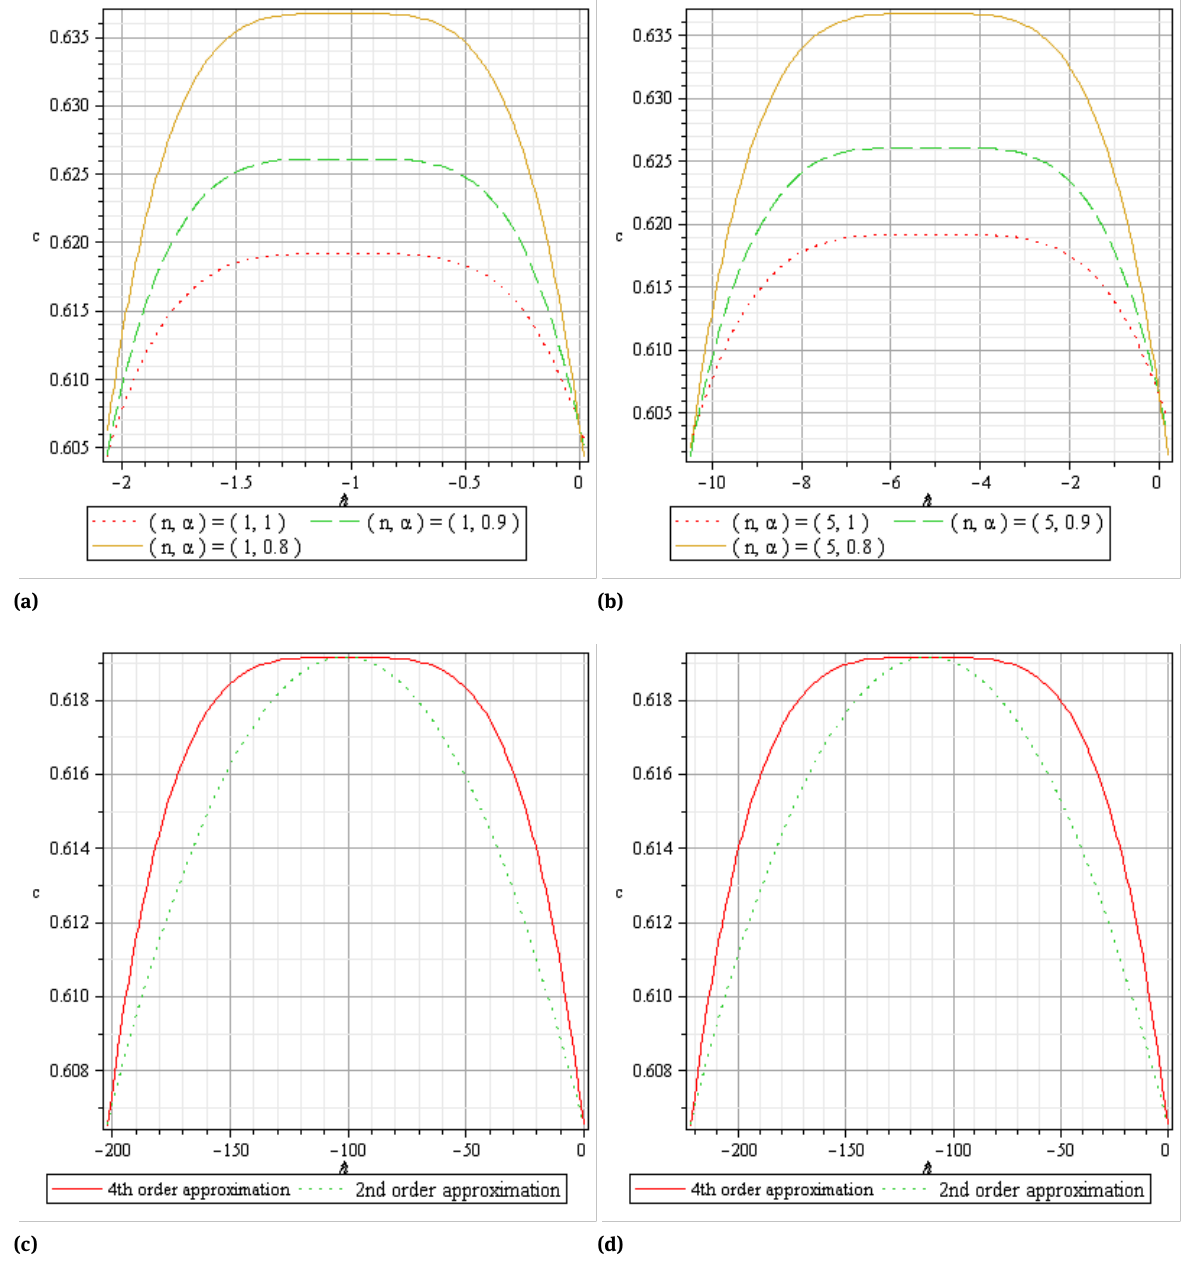
Fig. 9: (cid:126) -curves for fourth order approximation q -FHATM solution of Eq. (43) at x = 0.5, t = 0.02 and k = 0.03 , for (a) n = 1 , (b) n = 5 , (c) n = 100 , (d) n = 110